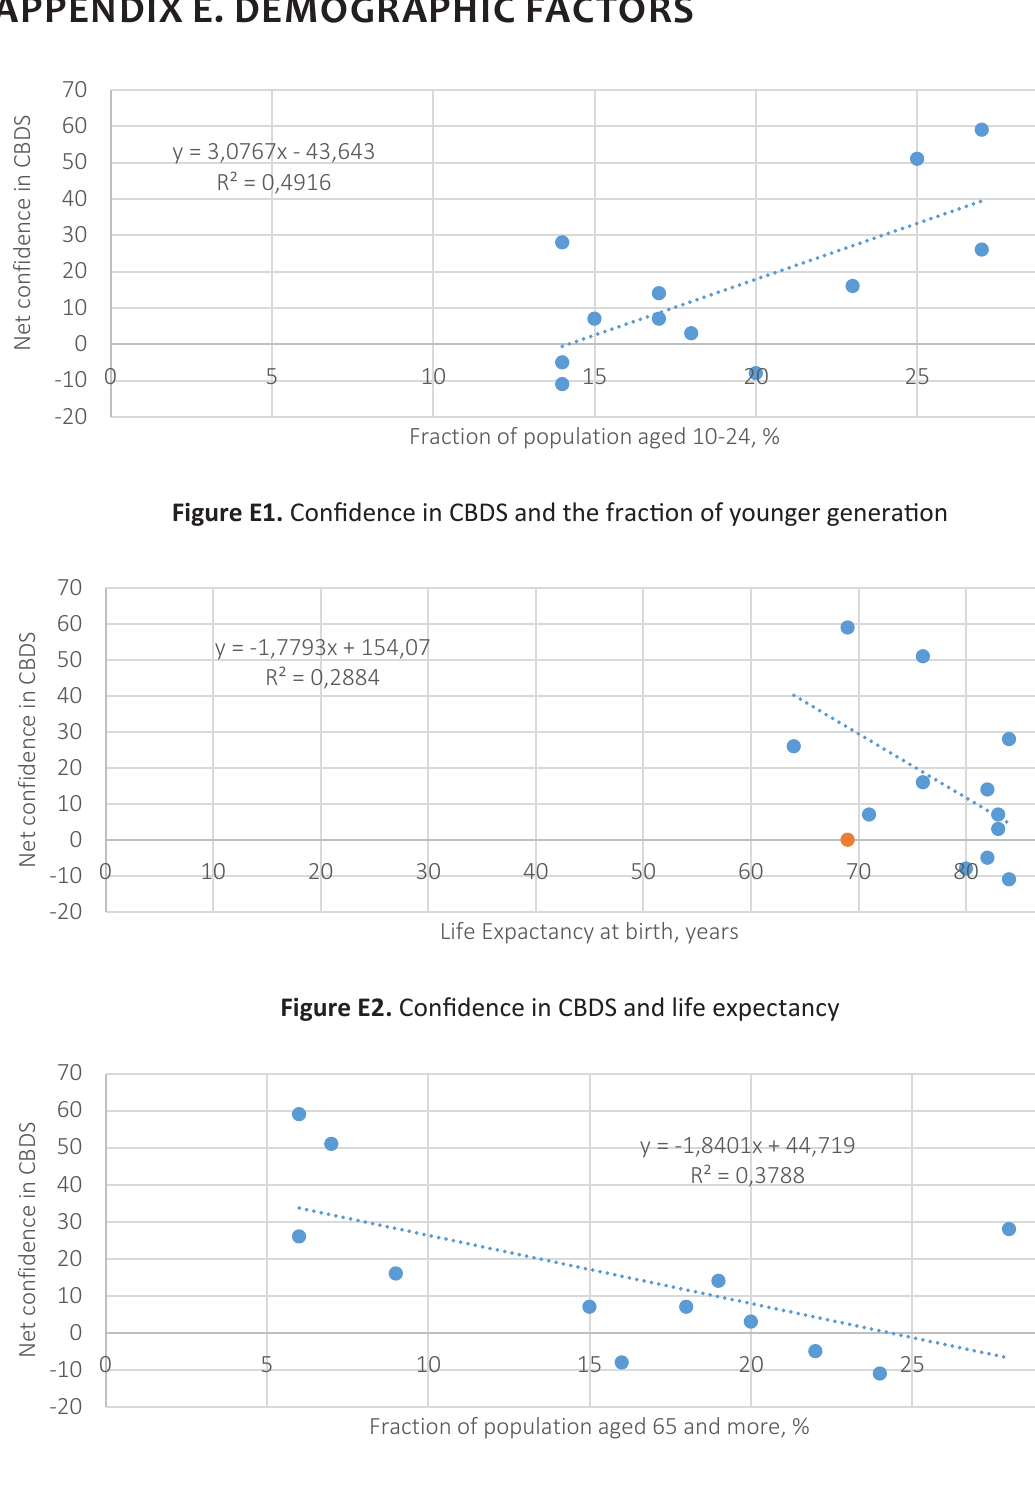
Figure Е3. Confidence in CBDC and the fraction of older